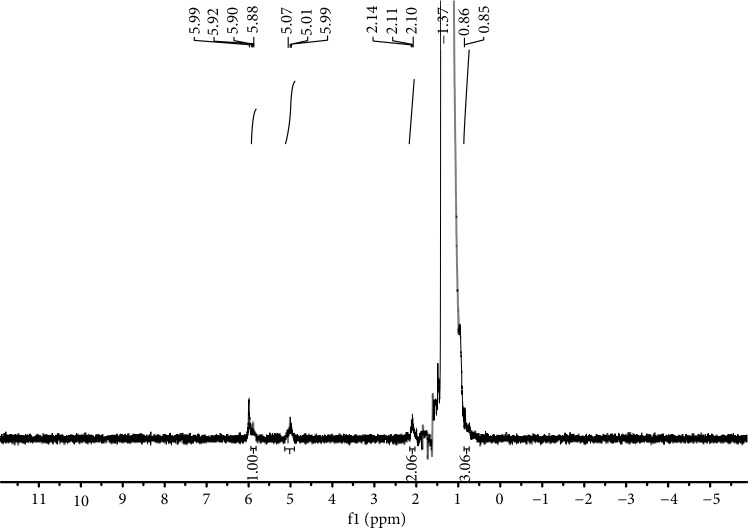

1H NMR spectrum of the polyethylene generated using Fe4/MAO at 60°C in C2D2Cl4 (run 9, Table 4).